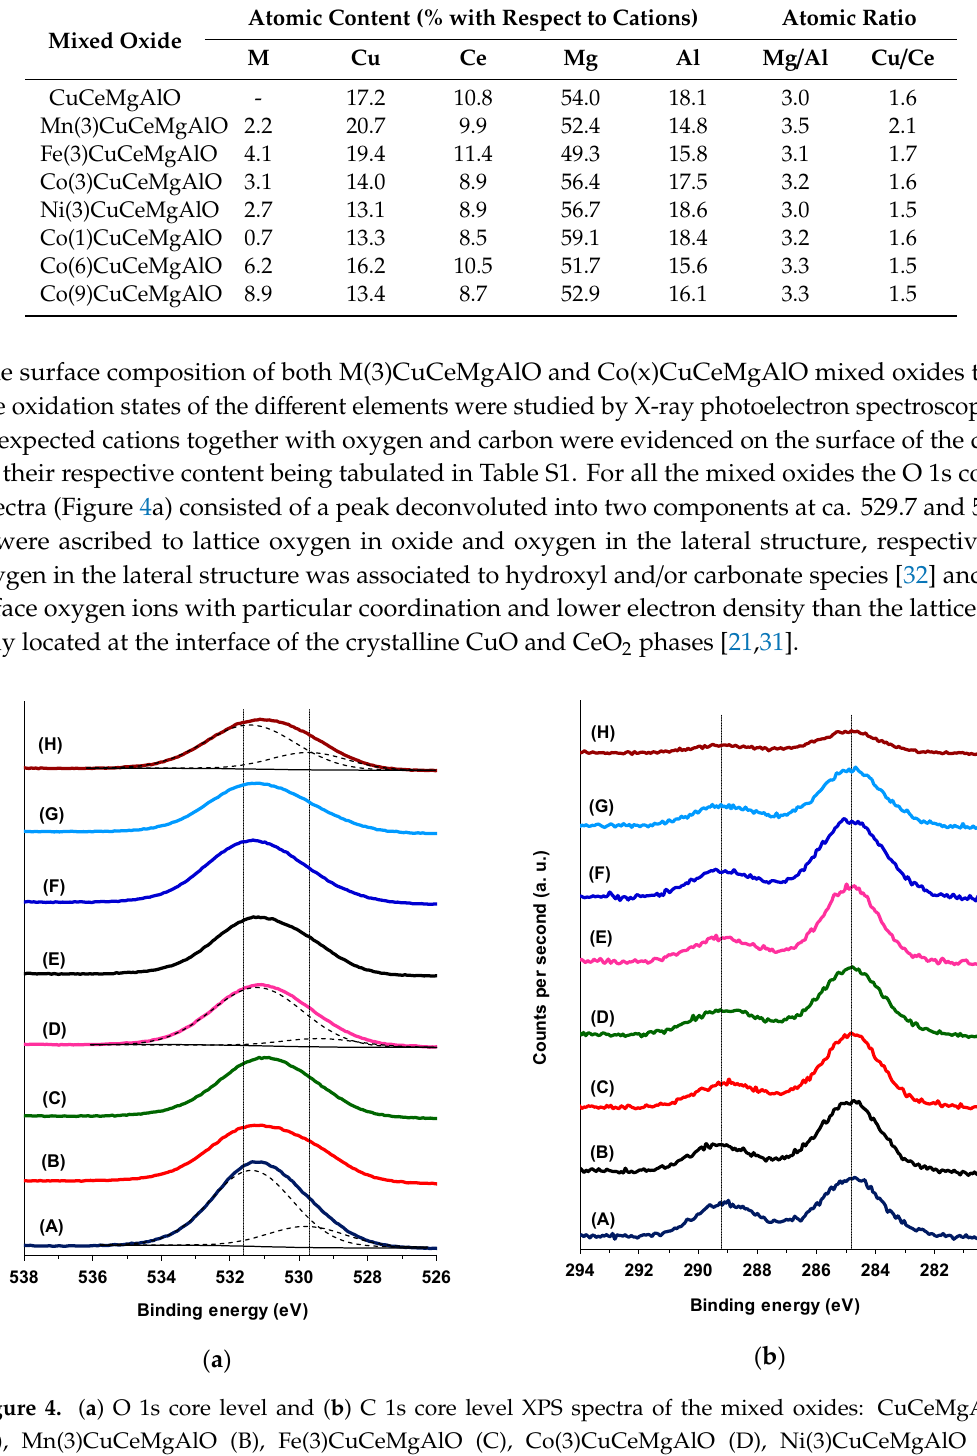
Table 3. Cationic composition of the calcined oxide catalysts estimated by EDX spectroscopy. Mixed Oxide